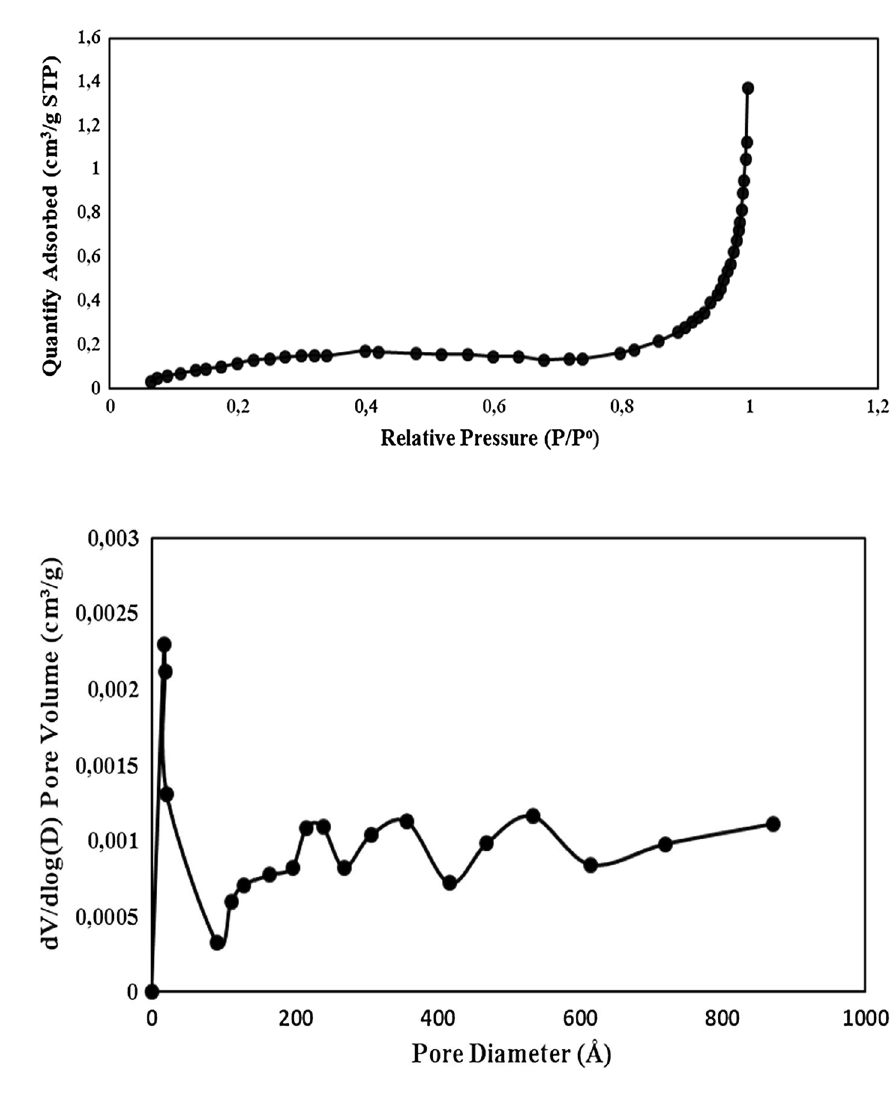
Fig. 2 Nitrogen adsorption isotherm of the LPF